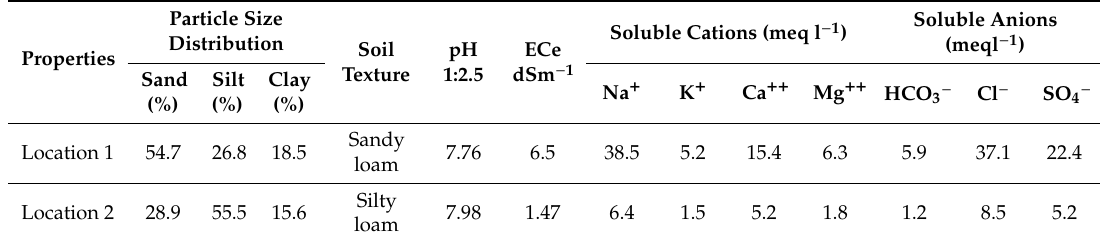
Table 1. Physico-chemical properties analysis of non-saline and saline soils used for the field trials.